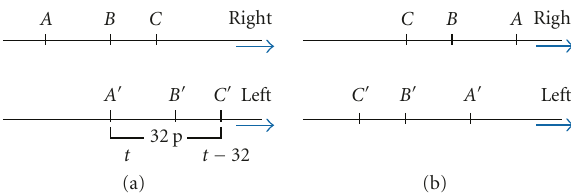
Figure 4: (a) Pixel B on the right scanline is compared for similarity with 32-pixels A (cid:2) – C (cid:2) of the left scanline stored in the delay line. (b) Scanlines are mirrored for consistency check: Pixel B (cid:2) on the left scanline is compared with all 32-pixels C–A on the right scanline.